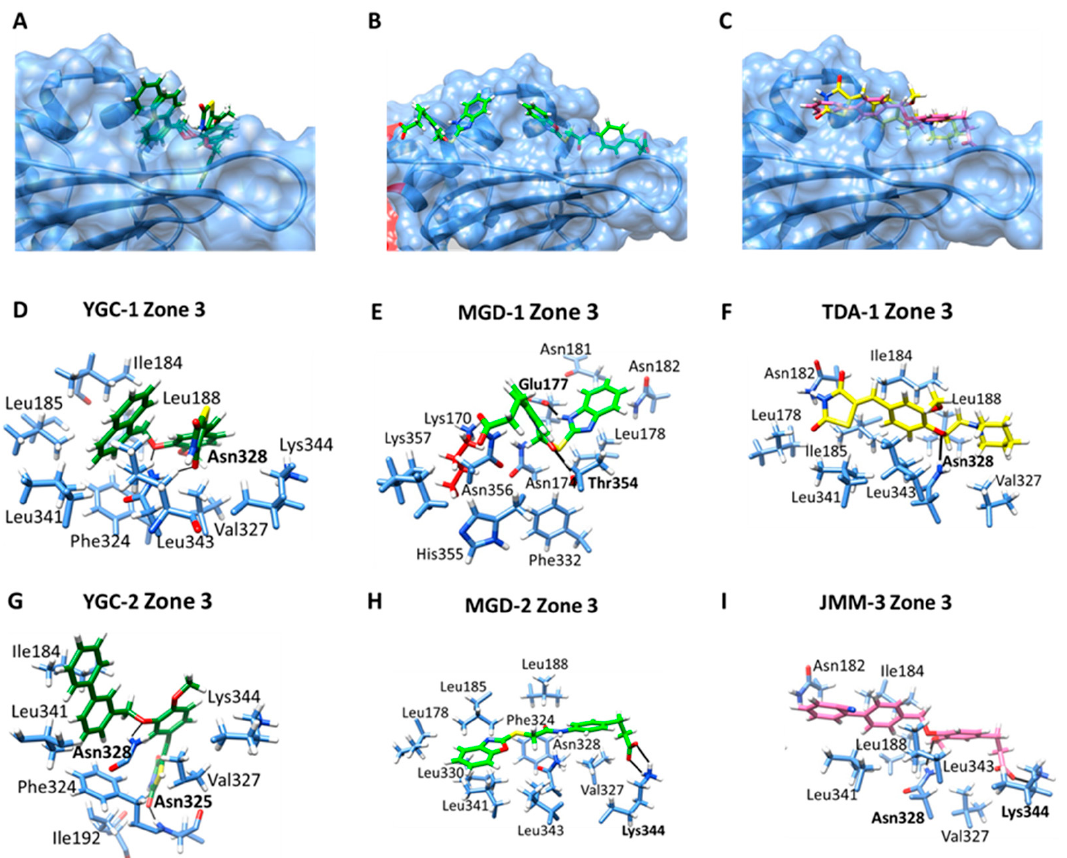
Figure 8. Molecular docking of compounds in zone 3 on the HpG6PD model. A general view of the binding cavities with the HpG6PD protein of ( A ) YGC-1 and YGC-2 ; ( B ) MGD-1 and MGD-2 ; and ( C ) TDA-1 and JMM-3 ; ( D , G ) zoom on the interactions of YGC-1 and YGC-3 ; ( E , H ) zoom on the interactions of MGD-1 and MGD-2 ; and ( F , I ) zoom on the interactions of TDA-1 and JMM-3 ligands with the HpG6PD model. The H-bond interactions are shown in black, and the amino acid residue is marked in bold.